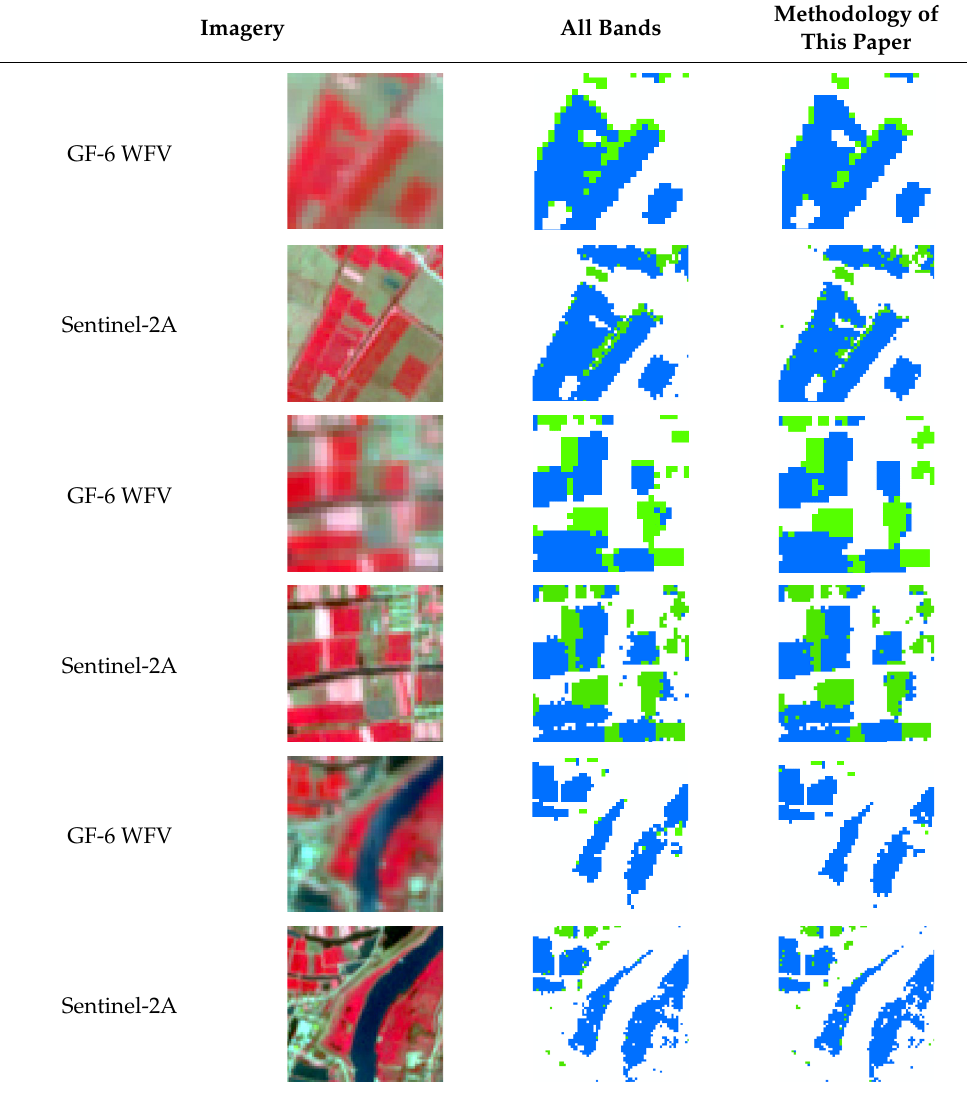
Table 9. Quantitative comparison of GF-6 WFV and Sentinel-2A data band sensitivities. Imagery